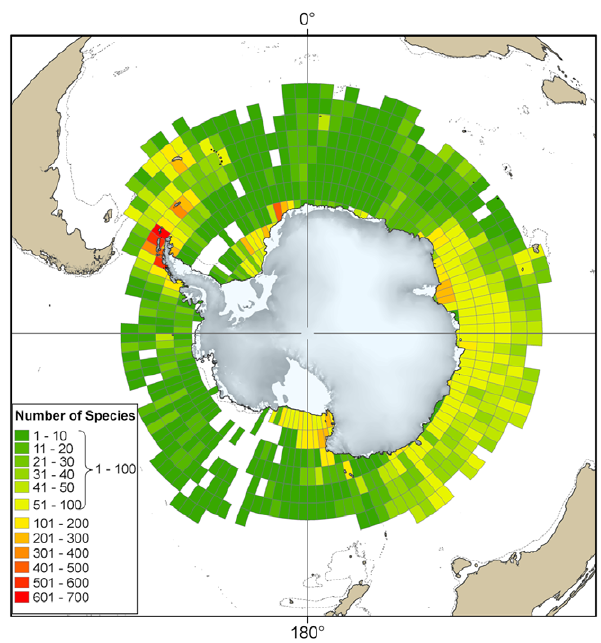
Figure 7. Counts of recorded species within the Southern Ocean. The total numbers of all marine species from distribution records in SCAR- MarBIN found within each 3 u of latitude by 3 u of longitude grid square.